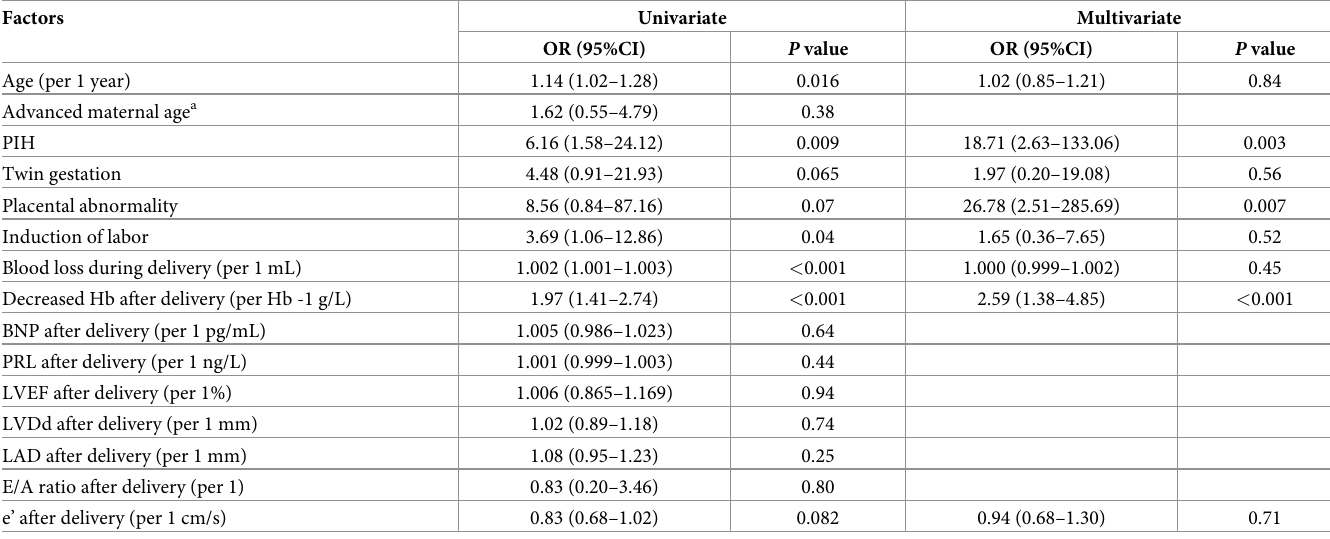
Table 3. Factors associated with elevated cardiac troponin I levels after